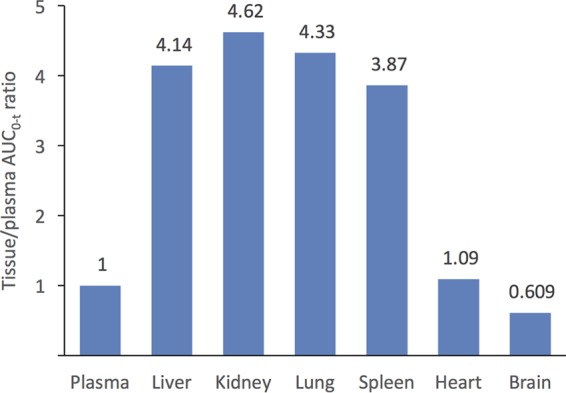
Tissue/plasma AUC0–t ratio of CD101 following intravenous administration of 5 mg/kg in rats.